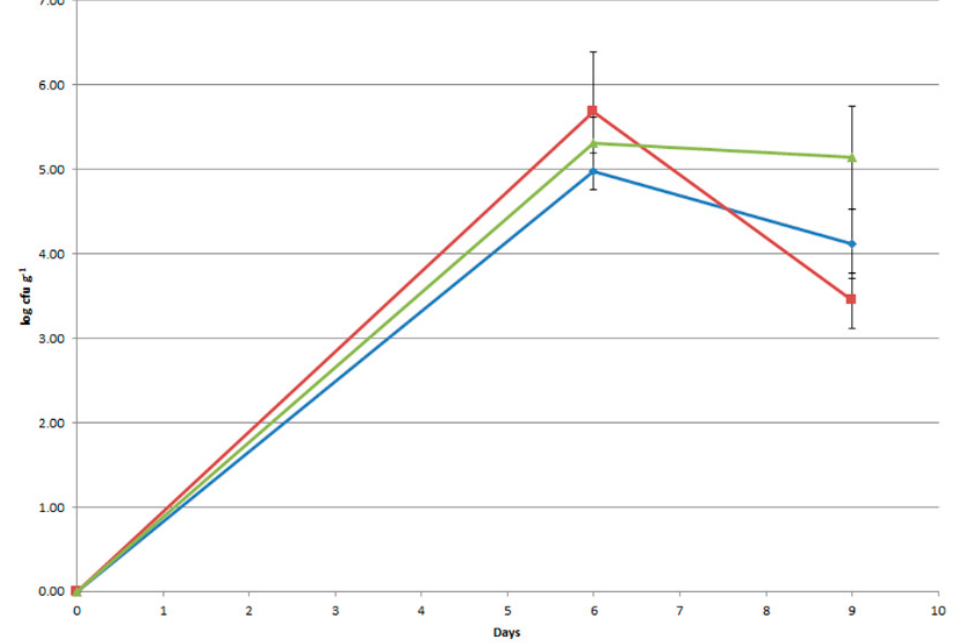
Figure 8. Lb. rhamnosus LR04 counts from the feces of three healthy volunteers (different colors) fed with Caciotta cheese containing the probiotic identified by species-specific and RAPD-PCR.